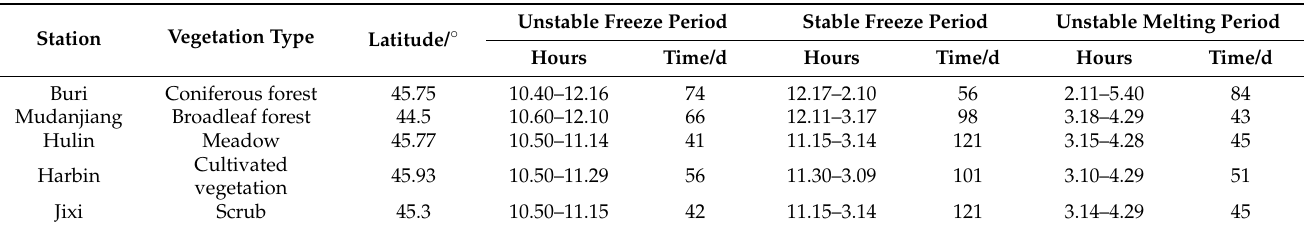
Table 2. Soil freeze–thaw process segments for the representative stations of the freeze–thaw cycle period of